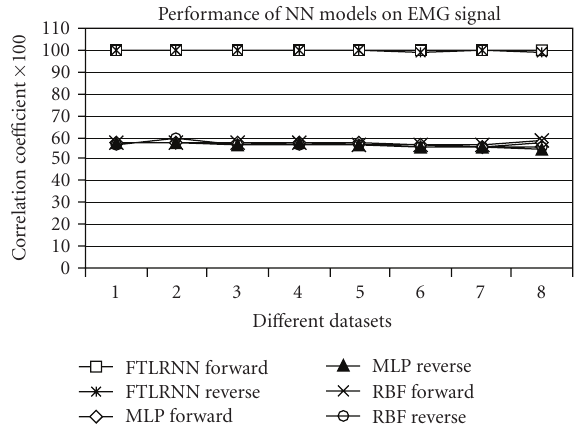
Figure 17: Correlation coe ffi cient with various datasets. Performance of NN models on multifold datasets for EMG signal